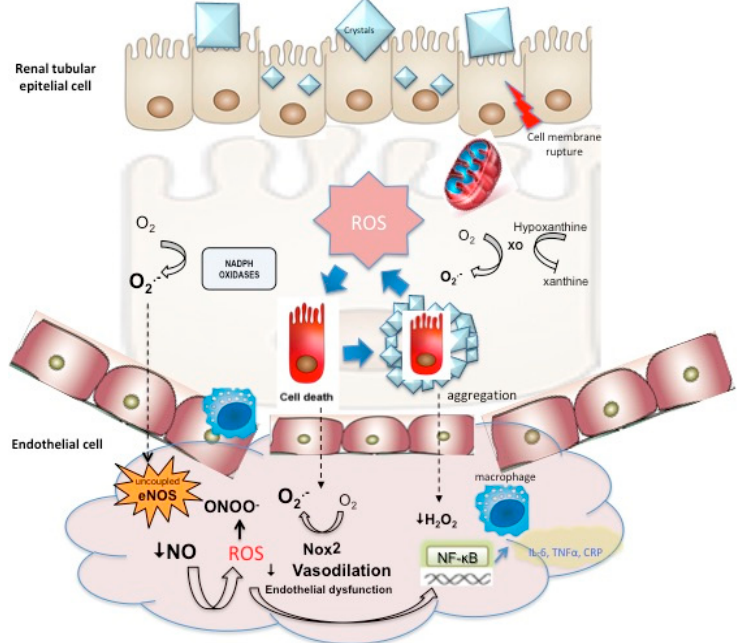
Figure 1. Interaction between oxidative stress-mediated epithelial cell injury, cell death, and stone formation with endothelial dysfunction triggered by impaired endothelium-dependent vasodilation augmented ROS and inflammatory response. Table 1. Characteristics of metanalysis and clinical studies in which association between urolithia- sis and cardiovascular morbidity has been studied. CHD: Coronary heart disease. CAD: Coronary artery disease. MI: Myocardial infarction.